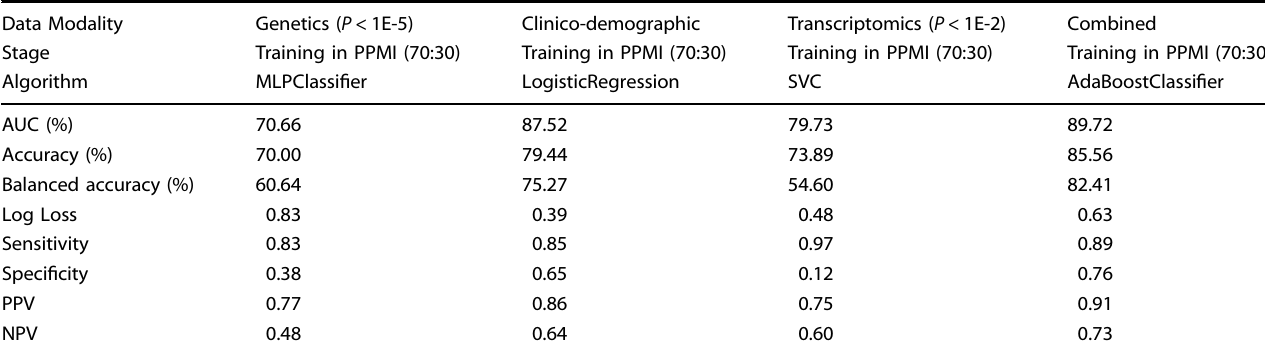
Table 2. Performance metric summaries comparing training in withheld samples in PPMI. Data